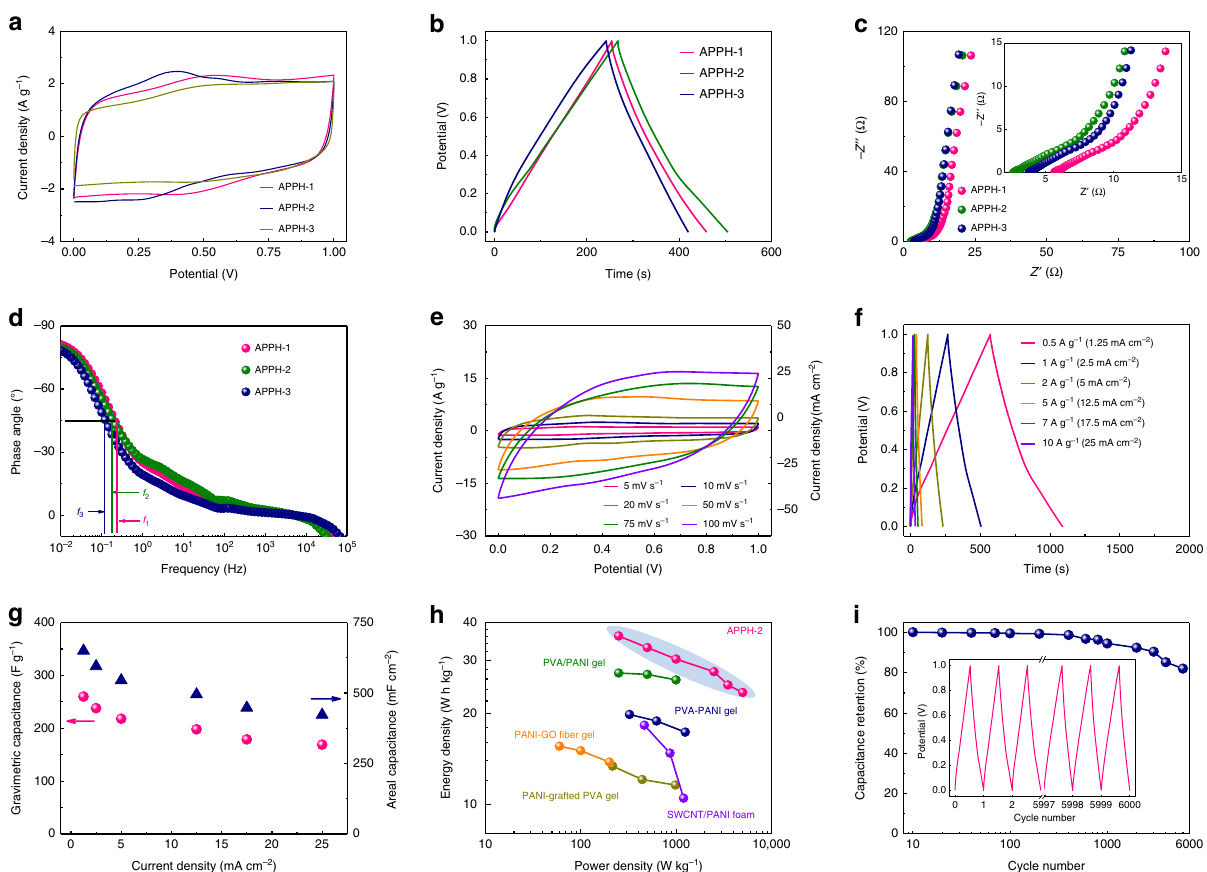
Fig. 5 Electrochemical performance of the anisotropic hydrogel electrodes. a Cyclic voltammetry (CV) curves of the all-solid-state supercapacitor (A- SC) with anisotropic polyvinyl alcohol/polyaniline hydrogel-1 (APPH-1), anisotropic polyvinyl alcohol/polyaniline hydrogel-2 (APPH-2) and anisotropic polyvinyl alcohol/polyaniline hydrogel-3 (APPH-3) electrodes, respectively, at a scan rate of 10 mV s − 1 . b Galvanostatic charge/discharge (GCD) curves of the A-SC with APPH-1, APPH-2 and APPH-3 electrodes, respectively, at a current density of 1 A g − 1 . c Nyquist plots of the A-SC with APPH-1, APPH-2 and APPH-3 electrodes, respectively. Inset of c showing high-frequency region of Nyquist plots. d Bode plots of the A-SC with APPH-1, APPH-2 and APPH-3 electrodes, respectively. e CV curves of the A-SC with APPH-2 electrodes at different scan rates. f GCD curves of the A-SC using APPH-2 electrodes at different current densities. g Gravimetric and areal capacitances of the A-SC with APPH-2 electrodes at different current densities. h Ragone plots of the A- SC with APPH-2 electrodes in comparison to other reported supercapacitors with 3D conducting polymer electrodes. i Cycling performance of the A-SC with APPH-2 electrodes for 6000 cycles. Inset of i showing GCD curves during the fi rst and last three A-SC, and the fi tting parameters are summarized in Supplemen- tary Table 6. Increased equivalent series resistance ( R s ) and